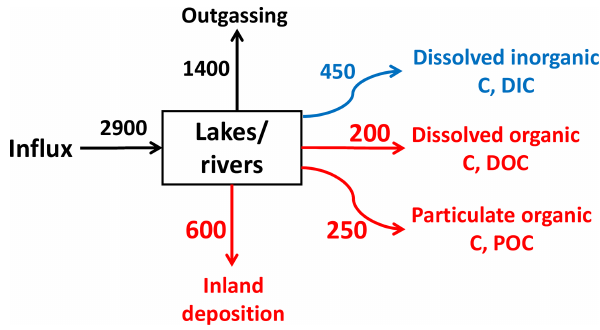
Figure 5. The main carbon fluxes in MtCyr − 1 involving inland wa- terways. The number shown in blue is already included in the global carbon budget, whereas the numbers in red should be added to the revised global carbon budget. The numbers in black do not need to be included